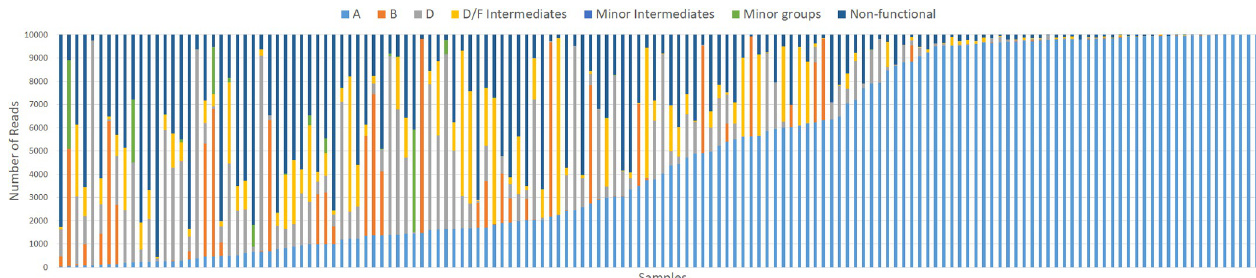
Fig 1. Number of env reads assigned to each KoRV group for each sample.